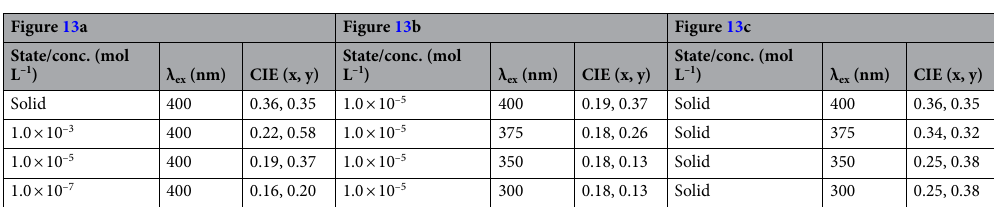
Table 4. CIE coordinates of the emission colors for the spectra in Fig.